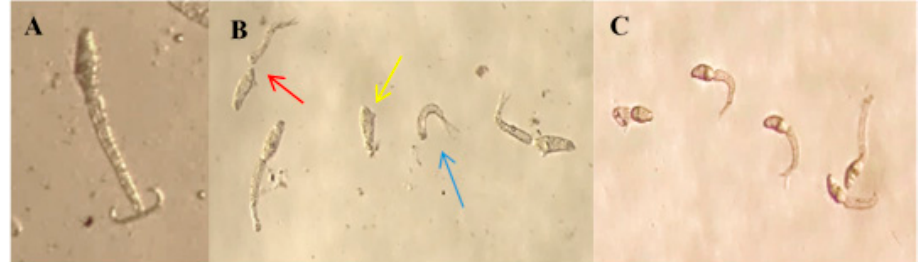
Figure 4. Cercariae of S. mansoni exposed to BAR. ( A ) Image of cercariae treated with 0.5% ethanol and filtered water, showing preservation of the body and tail; ( B ) Image of cercariae exposed for 30 min to 1 µg/mL BAR, showing a split between the body and tail (red arrow); an individual body (yellow arrow) and tail (blue arrow) are also displayed; ( C ) Image of dead cercariae after exposure to niclosamide (1 µg/mL). 40× magnification.